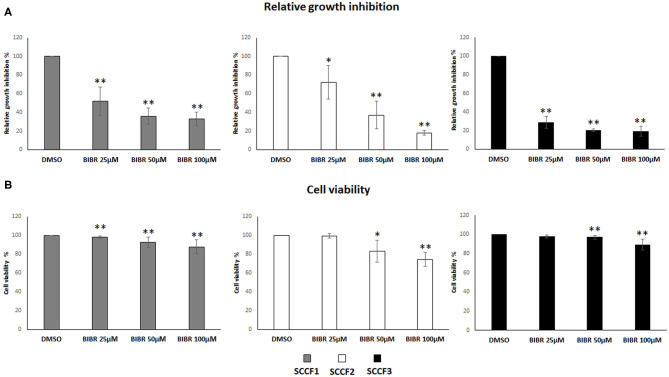
BIBR1532 inhibits cell growth and decreases cell viability in FOSCC cell lines. (A) SCCF1, SCCF2, and SCCF3 were treated with BIBR1532 at 25, 50, and 100 μM vs DMSO and analyzed by cell counting. The inhibitory effect on cell growth of each dose of BIBR1532 was calculated and expressed as % of decrease compared with its respective DMSO control set as 100%. Mean ± standard deviations (SD) from at least four independent experiments are shown. (B) Cell viability assessed by trypan blue exclusion assay. The effect of each dose of was calculated and expressed as % of decrease compared with its respective DMSO control set as 100%; the plots represent mean ± SD from at least four independent experiments (statistically significant, *P < 0.05; **P < 0.01).